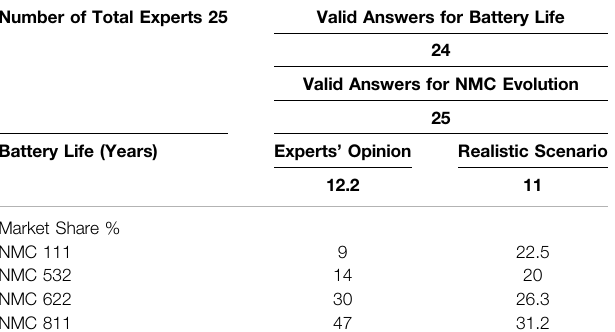
Table 5 | Executive summary of the